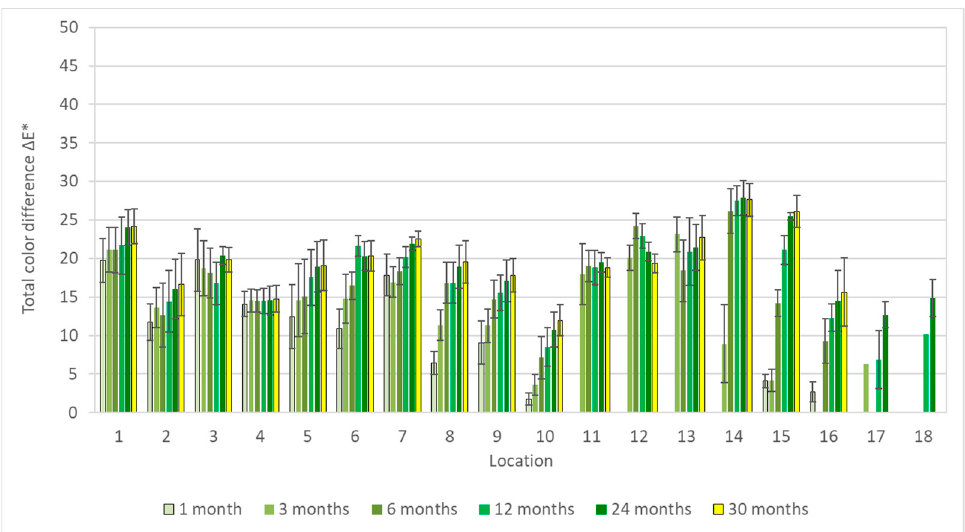
Figure 8. Details of zinc coupons from a church of location 15 ( left ), a wooden box with acetate film ( middle ), and a library from location 5 ( right ).